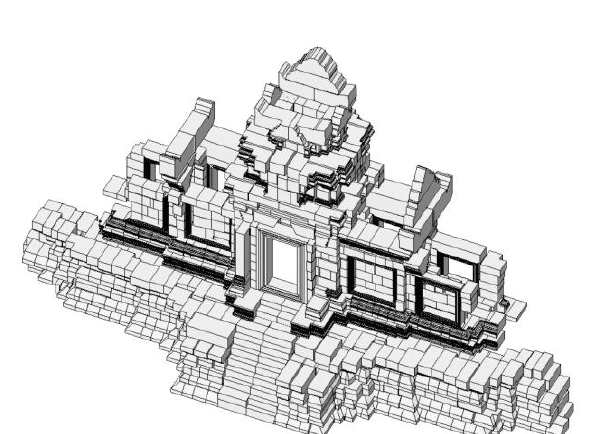
Figure 8. BIM model for the Outer South Gate of Ta Keo Temple, Angkor Monuments, Cambodia